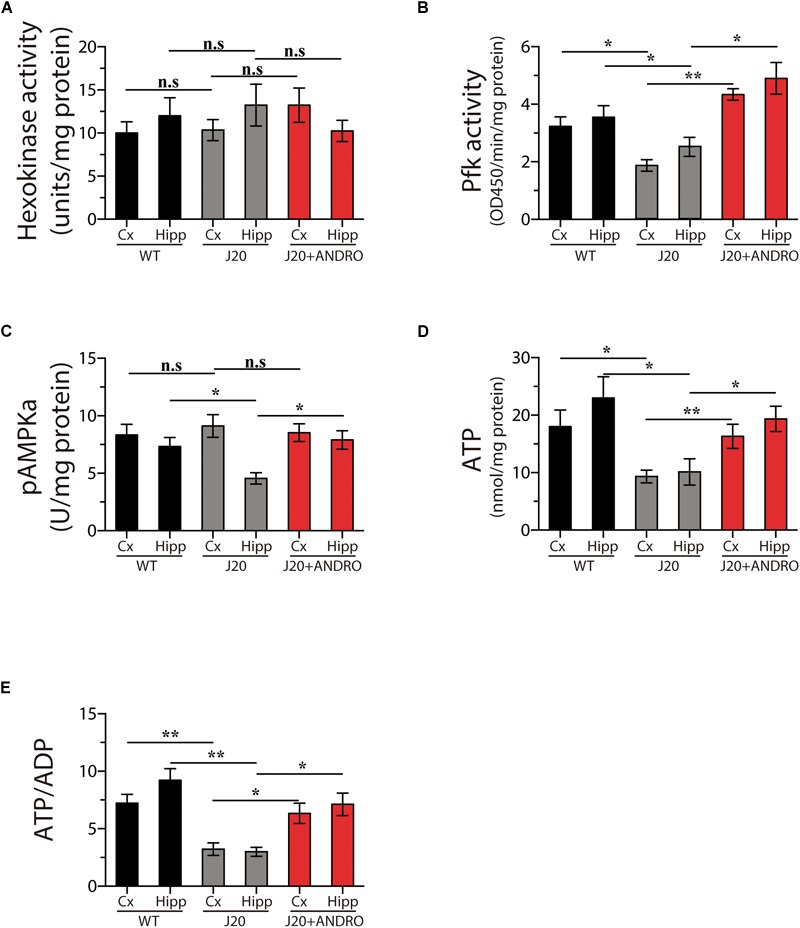
ANDRO treatment induces recovery of general brain metabolism. Treatment with ANDRO stimulated the enzymatic activity of two checkpoint proteins of glycolysis: HK (A) and Pfk (B). Effects of treatments on the levels of AMPK, an important metabolic sensor of glucose metabolism (C). ATP (D) and the ATP/ADP ratio (E) were measured to correlate the previous parameters with the energy status of cells. ANDRO restored the levels of both parameters in J20 mice. Data represent the mean ± SEM of n = 3 (independent experiments), each performed in triplicate. p ≤ 0.05 (95% CI) was considered the threshold for statistical significance, Bonferroni test, p-values are indicated in the “Results” Section.